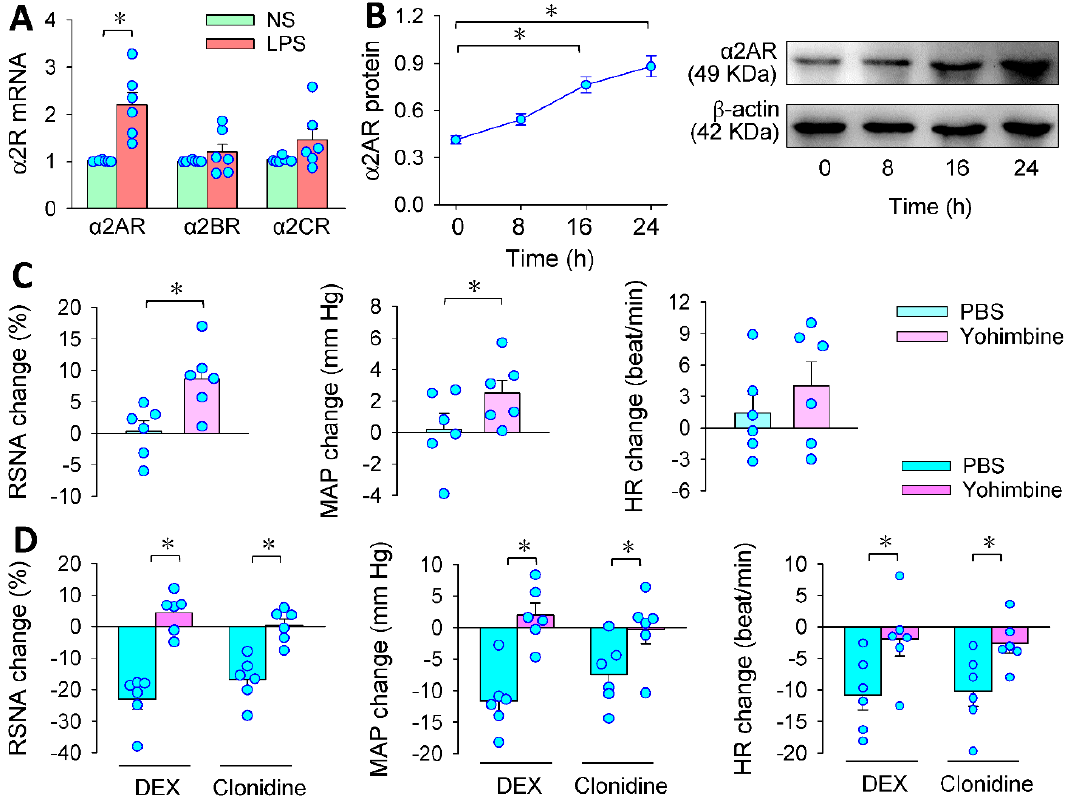
Figure 3. Roles of α 2 receptors ( α 2R) in the effects of DEX in LPS-treated rats. PVN microinjection was carried out 24 h after the intraperitoneal injection of LPS. ( A ) α 2R mRNA expressions in the